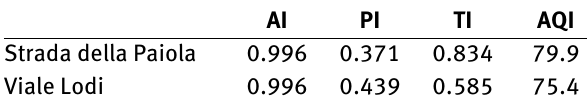
Table 3: Indicators and Index of the two roads AI PI TI AQI Strada della Paiola 0.996 Viale